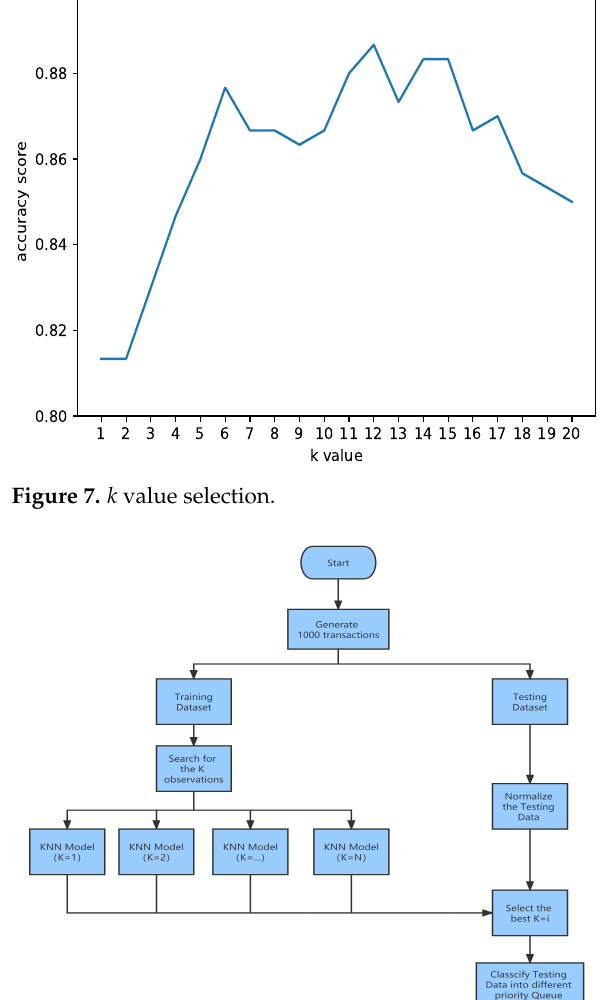
Figure 8. Transaction